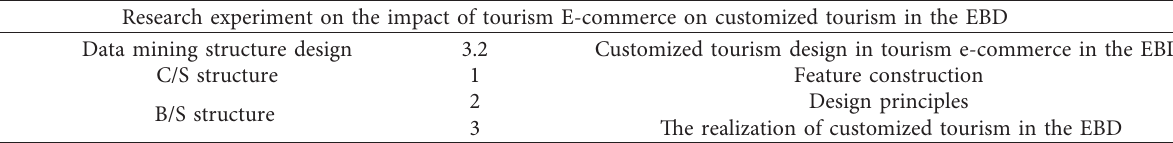
Table 2: Part of the technical process of the experiment in this paper.